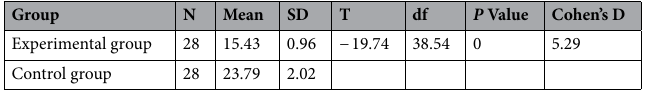
Table 3. Student cognitive load t-test.